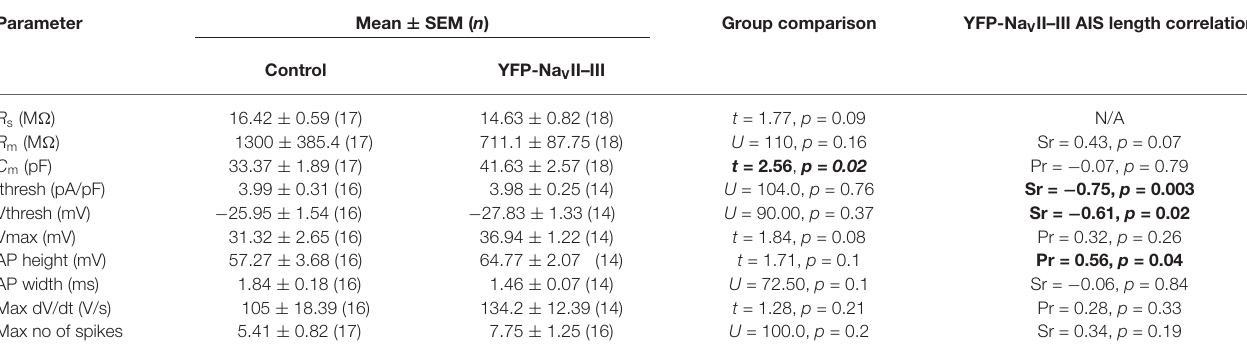
TABLE 3 | Physiological parameters of control or YFP-Na V II–III expressing dentate granule cells (DGCs) recorded under baseline conditions. Parameter Mean ± SEM ( n ) Group comparison YFP-Na V II–III AIS length correlation Control YFP-Na V